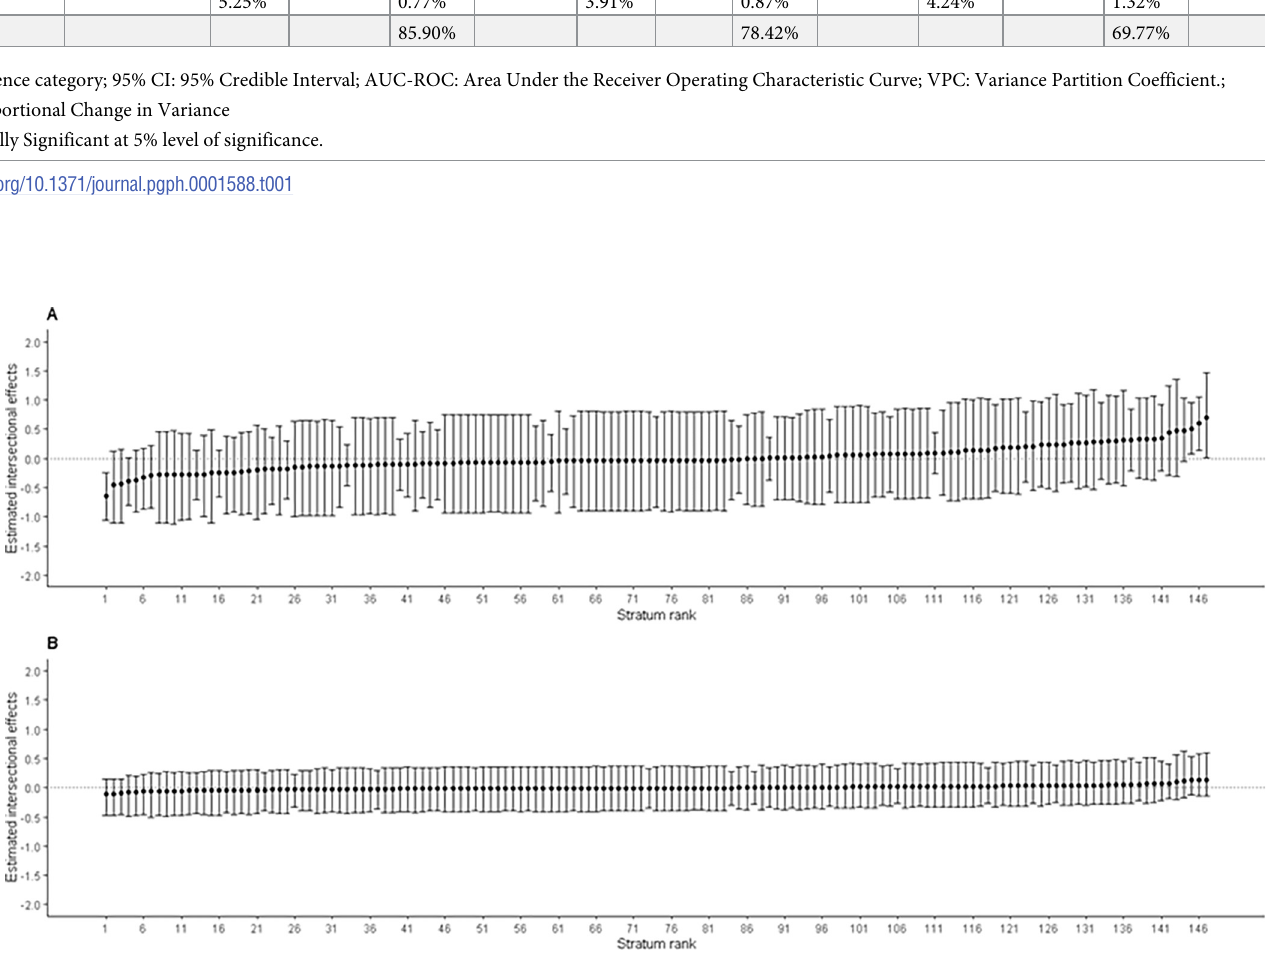
Fig 2. Estimated intersectional effects (stratum-level residuals) and their corresponding 95% credible intervals (CIs) for each stratum ranked from lowest to highest for cough. Panel A: An intercept model with only intersectional strata; Panel B: A Full model after adding main effects (variables used to create intersectional strata) with intercept model. Negative values indicate lower risk (privileged groups) of cough in under-five ‘than expected’ based on the additive contributions of the main effects, while positive values indicate higher risk (disadvantaged groups) of cough in under-five ‘than expected’ for that